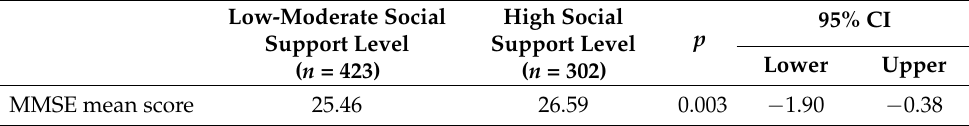
Table A1. Mean MMSE score of older adults of low–moderate social support level and high social support